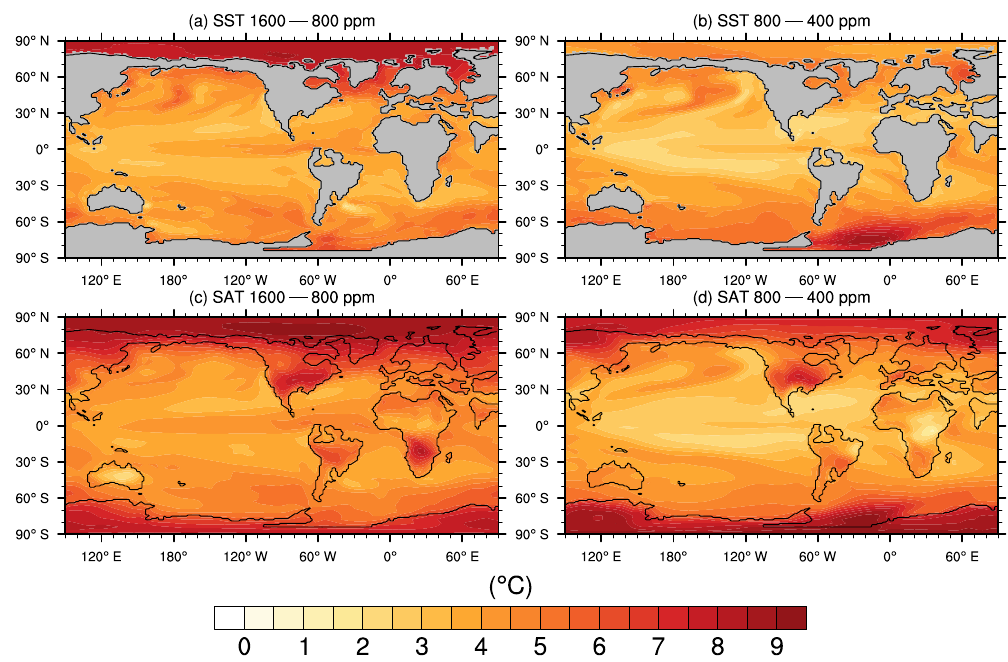
Figure 11. Sea surface temperature (SST) difference between (a) 1600–800ppm and (b) 800–400ppm and surface air temperature (SAT) difference between (c) 1600–800ppm and (d) 800–400ppm.